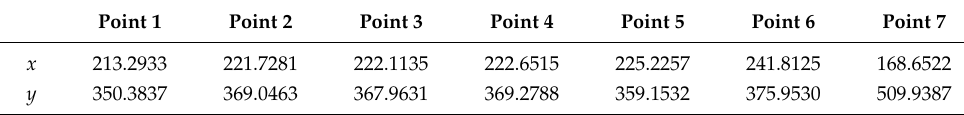
Figure 15. Intersection of experiment for Case I. Table 3. Coordinates of the intersections under experiment.